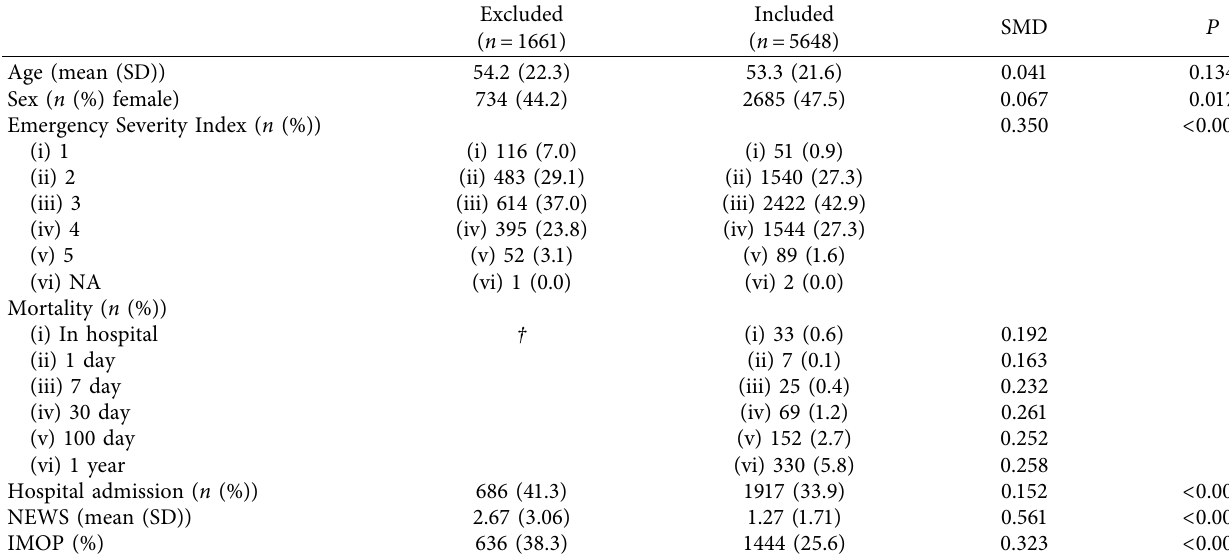
Table 1: Demographics of included and excluded presentations Data are shown as mean and SD for continuous variables and as count and percentage for categorical